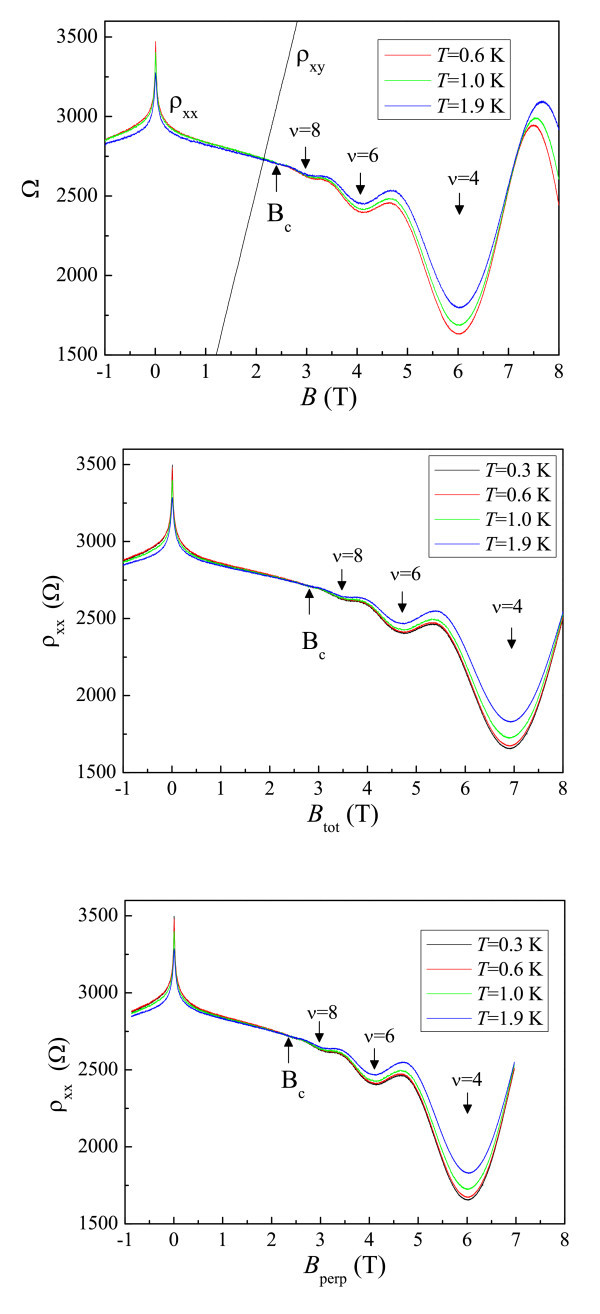
Four-terminal magnetoresistance measurements:(a) Longitudinal resistivity ρxx measurements as a function of magnetic field ρxx(B) at various temperatures. Hall resistivity ρxy as a function of B at T = 1.9 K is shown. (b) Longitudinal resistivity measurements as a function of total magnetic field ρxx(Btot) at various temperatures. (c) Longitudinal resistivity measurements as a function of the perpendicular component of the applied magnetic fieldρxx(Bperp) at various temperatures.